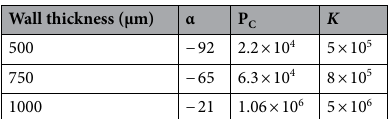
Table 1. The parameters used in the theoretical model to compare with the experimental results.